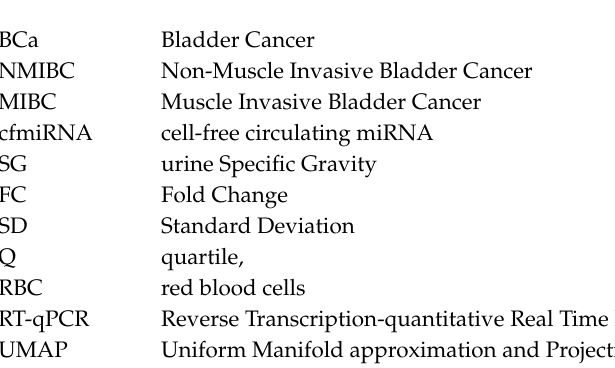
Table S4: Mean Ct and standard deviation (SD) of urine cfmiRNAs analyzed in the total cohort of patients and controls. Table S5: Evaluation of urine cfmiRNAs as biomarkers of low-risk vs high-risk BCa. Table S6: Univariate logistic regression models for the six miRNAs selected as urine biomarkers of high-risk BCa. Table S7: Ratios generated by combinations of the 14 urine cfmiRNAs examined. Table S8: Mean Ct and standard deviation (SD) calculated for miRNAs in plasma samples. Table S9: Univariate analysis of urine miRNAs associated with EFS in bladder cancer patients. Table S10: Univariate analysis of clinical characteristics of bladder cancer patients associated with EFS. Table S11: Urine parameters in patients and controls. Figure S1: Boxplots with the distribution of the two best candidate normalizers in urine. Figure S2: Evaluation of urine specific gravity and miRNA detection. Figure S3: Distribution of urine miRNA levels in controls and BCa patients. Figure S4: Scatter plot showing the criteria used to identify the six most upregulated urine miRNAs in high-risk vs low-risk patients. Figure S5: Evaluation of confounding factors: smoking and gender. Figure S6: Plasma miRNA levels across